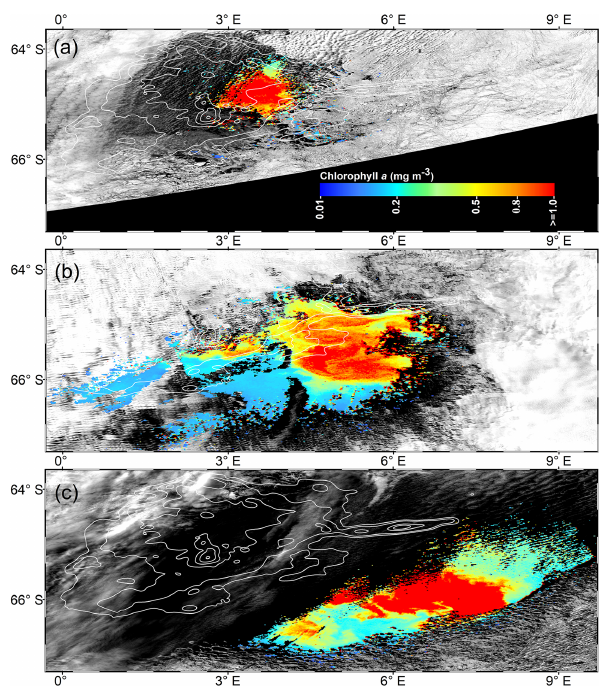
Figure 2. High-spatial-resolution ( ∼ 1km) Aqua MODIS ascend- ing passes on (a) 25 October (14:45), (b) 6 November (15:05), and (c) 21 November 2017 (14:25), showing the unprecedented phy- toplankton blooms in the Maud Rise polynya. The white contours show the extent of the Maud Rise seamount.